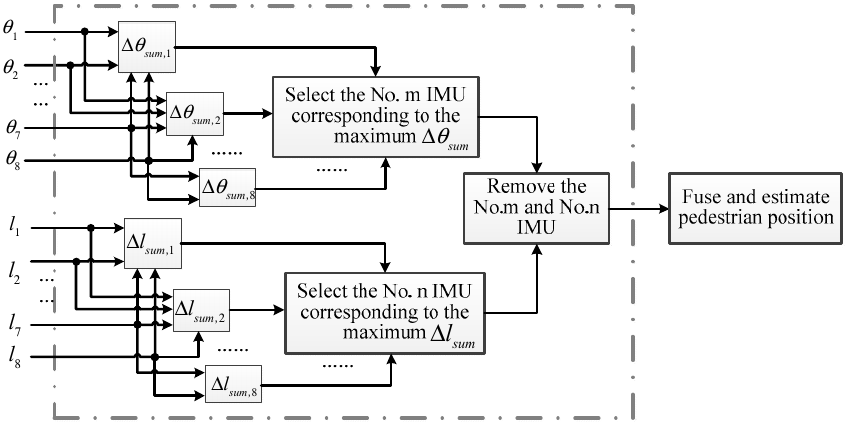
Figure 6. Pedestrian positions calculated by IMU with different drift errors during a step.